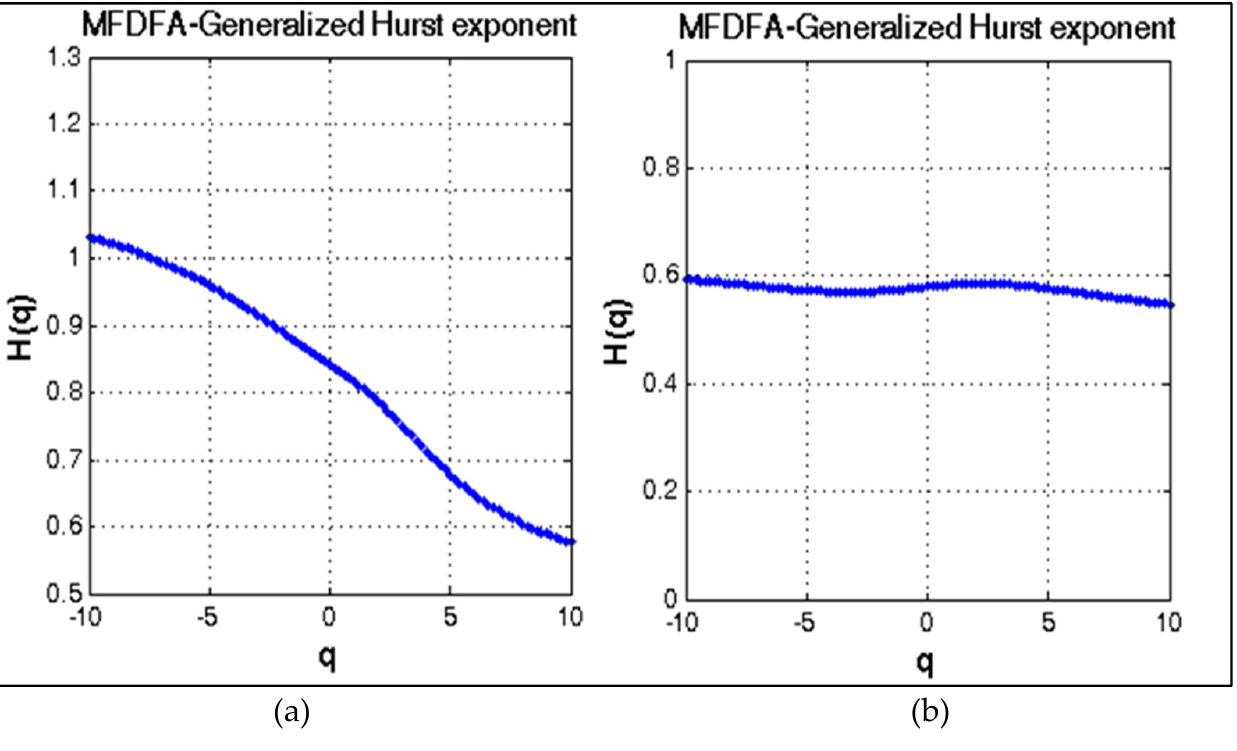
Figure 5. MFDFA method for determining the Hurst exponent ( a ) healthy subject with H(q = 2) = 0.8192 ( b ) sick patient (arrhythmia) with H(q = 2) = 0.5892.